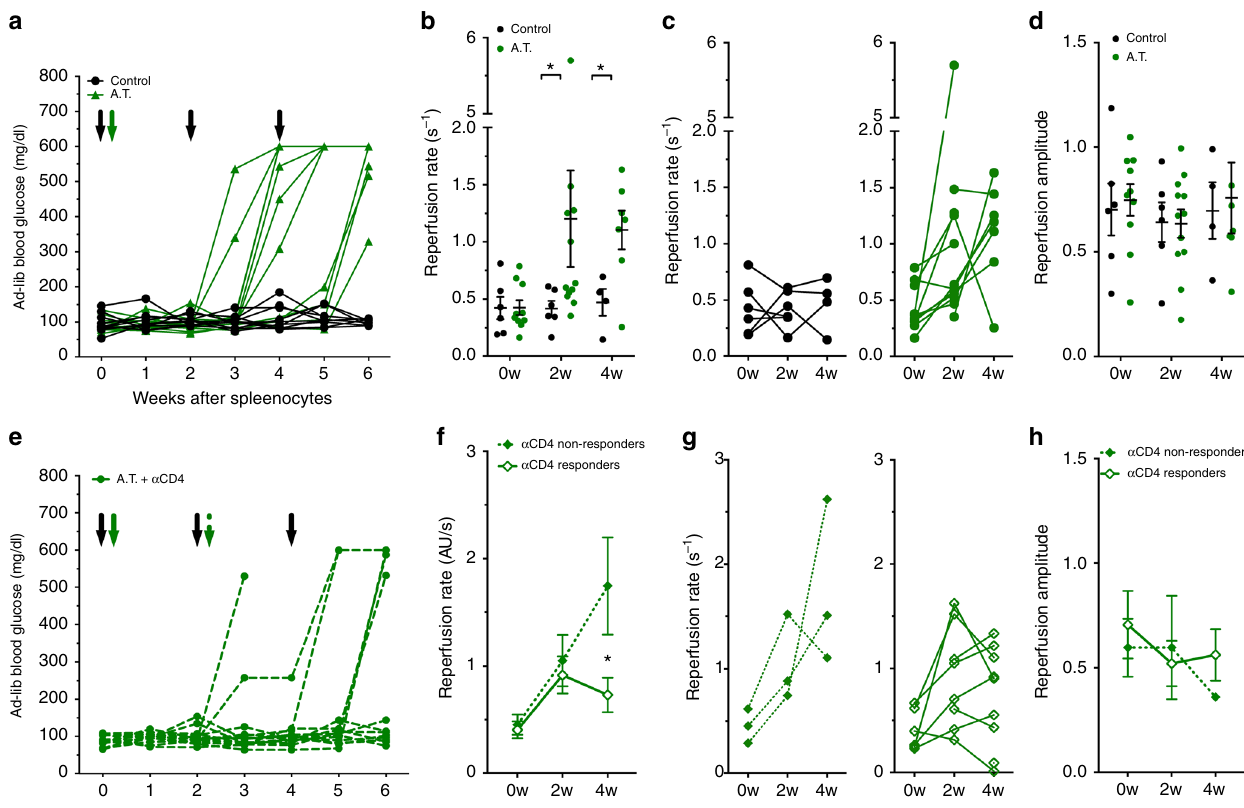
Fig. 5 CEUS non-invasively detects changes in pancreas blood fl ow dynamics associated with immunomodulatory halting of disease. a Ad-lib blood-glucose time courses in adoptive transfer animals treated with splenocytes from diabetic female NOD donors (A.T., green) or treated with buffer alone (Control, black). Black arrows indicate time points of CEUS scans, green arrow indicates delivery of splenocytes. b Reperfusion rate in A.T. animals (green) or control animals (black) at baseline (0w), 2 weeks (2w) and 4 weeks (4w) post splenocyte or vehicle transfer. c Data in b showing changes in individual mice for reperfusion rate. d As in b for reperfusion amplitude. e Ad-lib blood-glucose time courses of A.T. animals that were treated with 20 mg anti-CD4 antibody. Black arrows indicate time of CEUS scans, green solid arrow indicates time of splenocyte delivery, green striped arrow indicates time of anti-CD4 treatment. Animals that progressed to hyperglycemia within 6 weeks were denoted as non-responders. f Average reperfusion rate in anti-CD4 responders (open diamonds) and non-responders (closed diamonds) before (0w), 2 and 4 weeks post splenocyte transfer. g Data in f showing changes in individual responder and non-responder mice for reperfusion rate. h As in f for reperfusion amplitude. Error bars represent s.e.m. * p < 0.05, ** p < 0.01, *** p < 0.001 comparing groups indicated (paired t -test for data in c , g ; unpaired t-test for data in f , h ; ANOVA for data in b , d . Data in a – d represents n = 11 AT mice and n = 6 control mice, data in e – h represents n = 9 responder mice and 3 non-responder